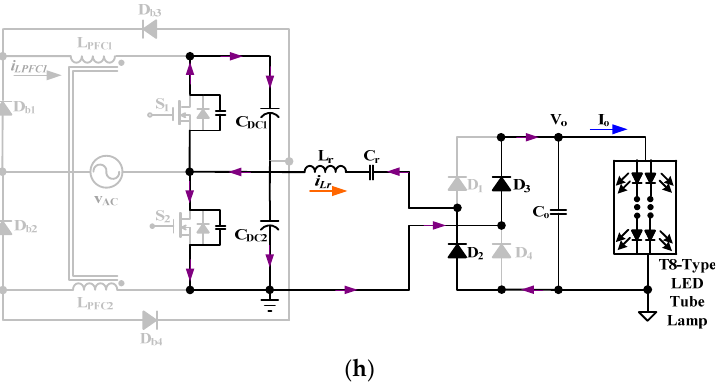
Figure 3. Operation modes of the presented driver during the positive half ‐ cycle of input voltage v AC .